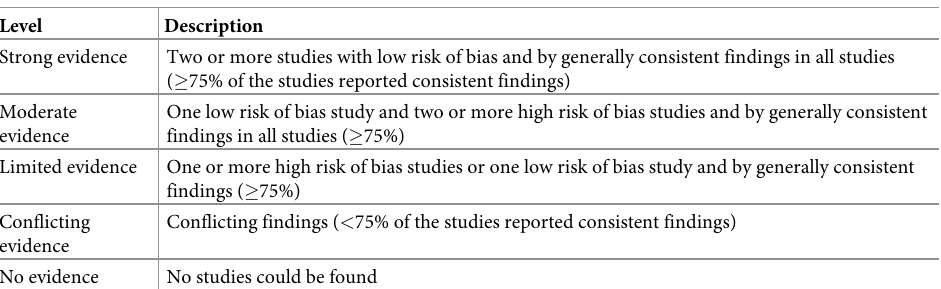
Table 1. Levels of evidence.